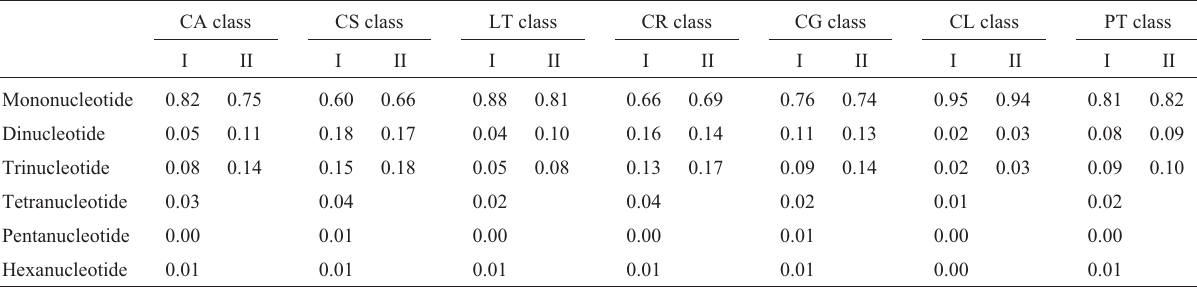
Table 3 - Frequency distribution (%) of the different SSR types (perfect repeats only) according to their potential as genetic markers. Definitions of these classes followed the pattern reported by Temnykh et al.